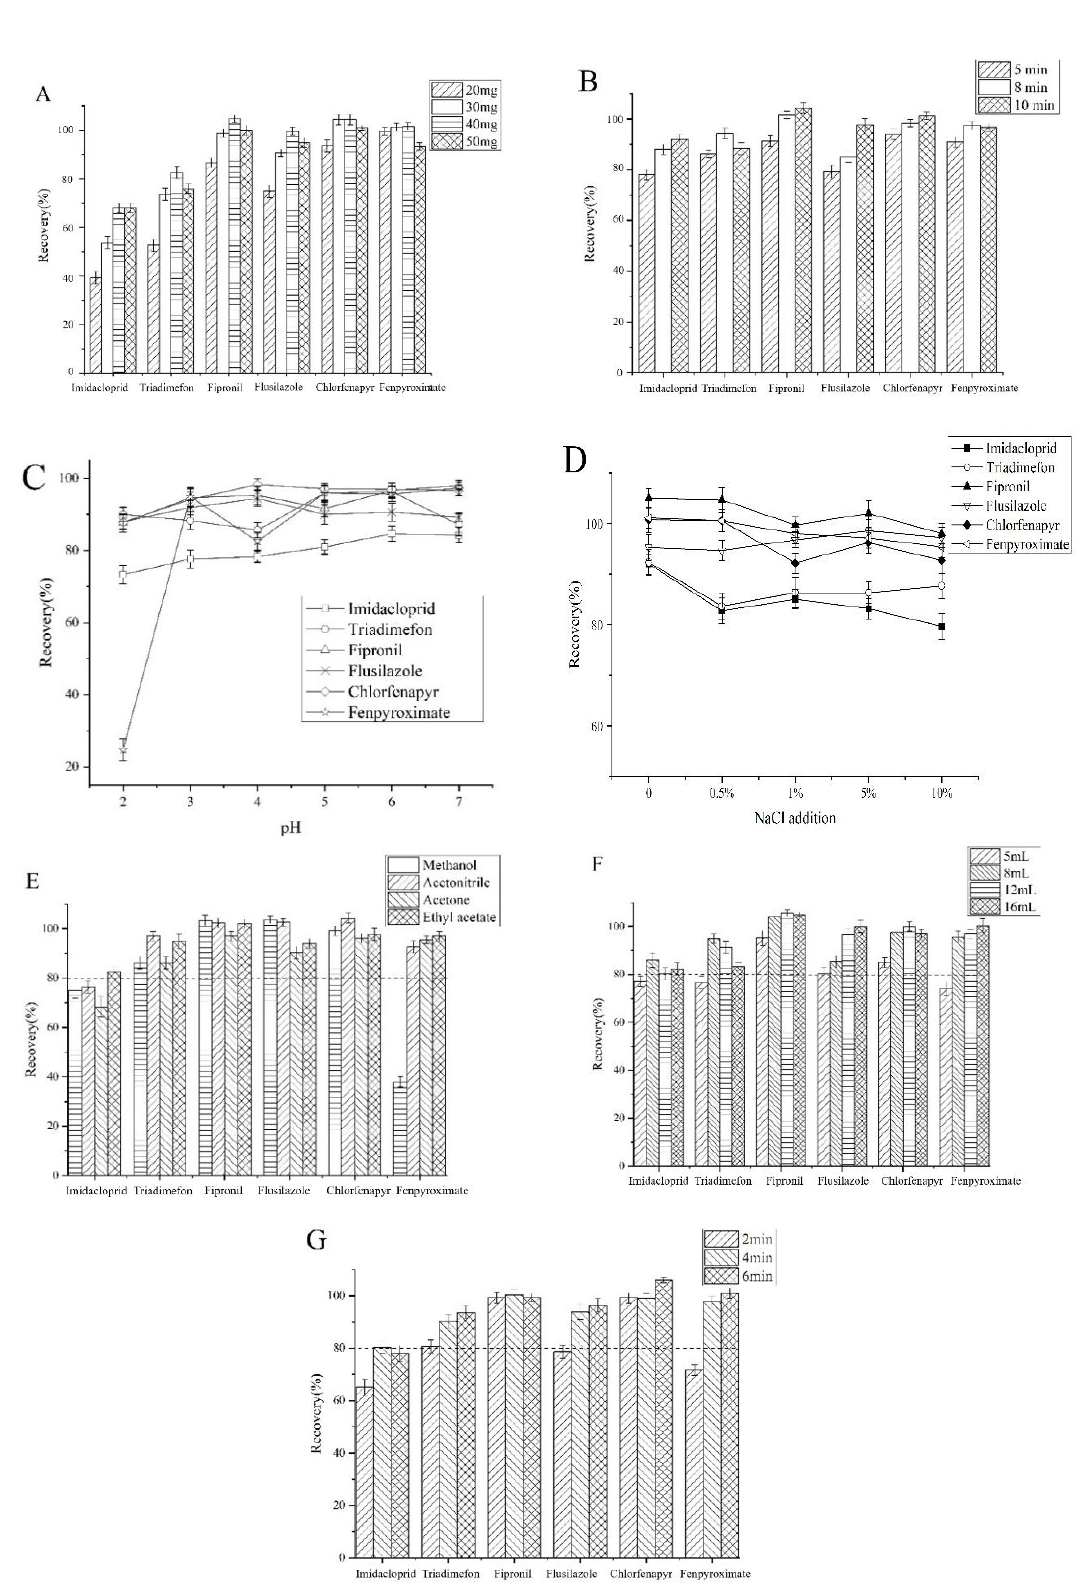
Figure 6. Effect of ( A ) the amount of mag-MWCNTs ( B ) extraction time, ( C ) sample pH, 6.0; ( D ) salt concentration, ( E ) type of desorption solvent, ( F ) volume of desorption solvent, and ( G ) desorption time.